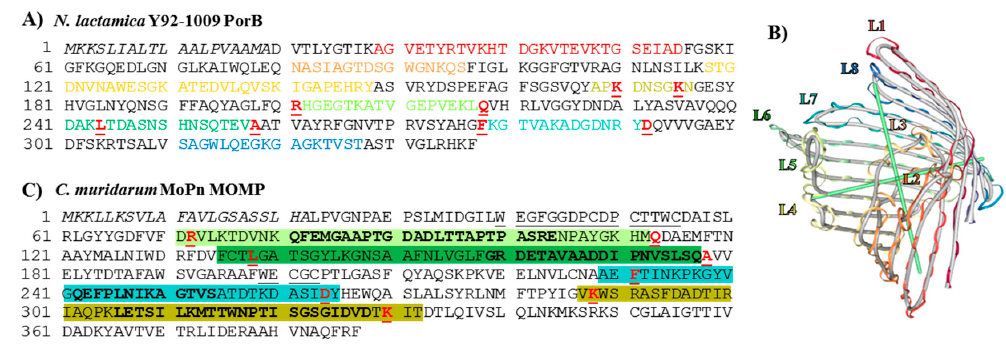
Figure 1. Cloning Strategy. ( A ) Sequence of N. lactamica Y92-1009 PorB. The leader sequence is indicated in italic. Loops are indicated as follows: L1 : Dark red. L2 : Orange. L3 : Ochre. L4 : Yellow. L5 : Lime green. L6 : Green. L7 : Teal. L8 : Blue. Residues in L4, L5, L6 and L7 for insertion of MOMP VDs are in bold underlined red; ( B ) Cartoon of the NL PorB monomer (side view) created with Swiss-Model server [63,64] and NGL Viewer 0.9.0 [65] based on the Nme PorB template (PDB ID 3WI4) [66]. The loops are color-coded as in ( A ). ( C ) Sequence of C. muridarum MOMP. The leader sequence is in italic. Loops are indicated as follows: L1 : Underlined. L2 : Lime green box with residues corresponding to VD1 bolded. L3 : Green box, VD2 residues bolded. L4 : Underlined. L5 : Teal box, VD3 residues bolded. L6 : Yellow box, VD4 residues bolded. Residues in L2, L3, L5 and L6 for insertion into PorB loops are in bold underlined red.